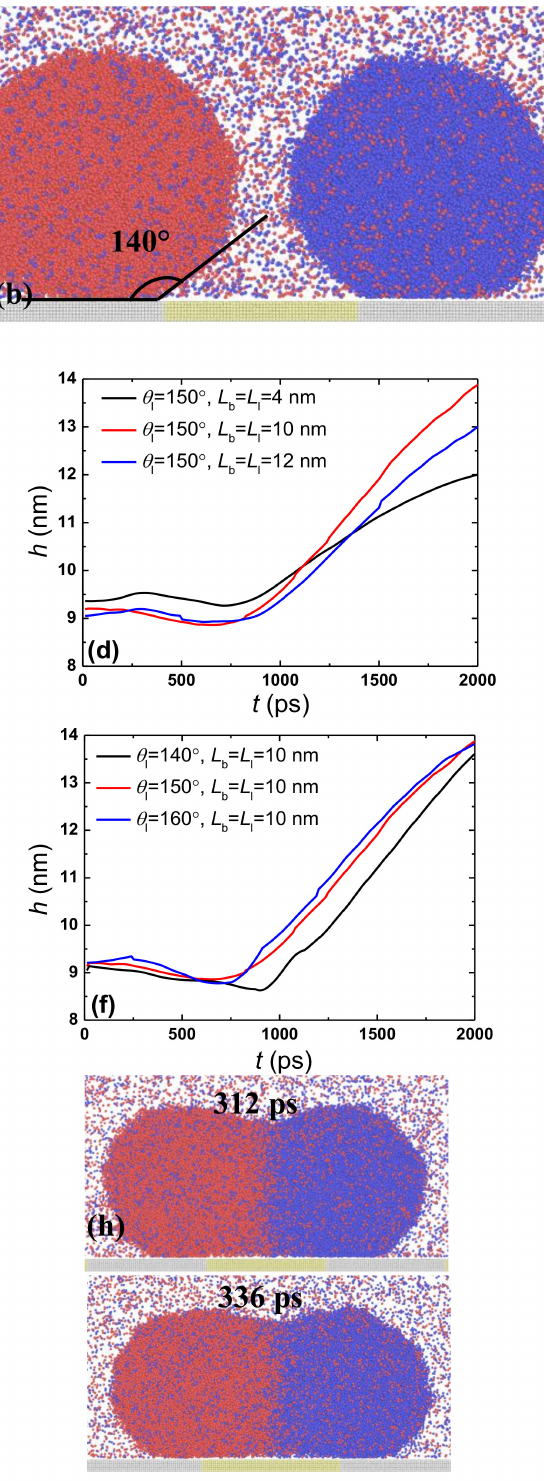
Figure 4. ( a , b ) Contact angles for L b = L l = 2 nm and L b = L l = 10 nm. ( c – f ) Evolution of droplets height of the mass center on different surfaces. ( g ) Transient component velocity in y-direction perpendicular to the surface and the value of jumping velocity in three different strip widths at contact angle of 140 ◦ . ( h , i ) The states of liquid bridge just impacting the substrate when L b = L l = 12 nm and L b = L l = 14